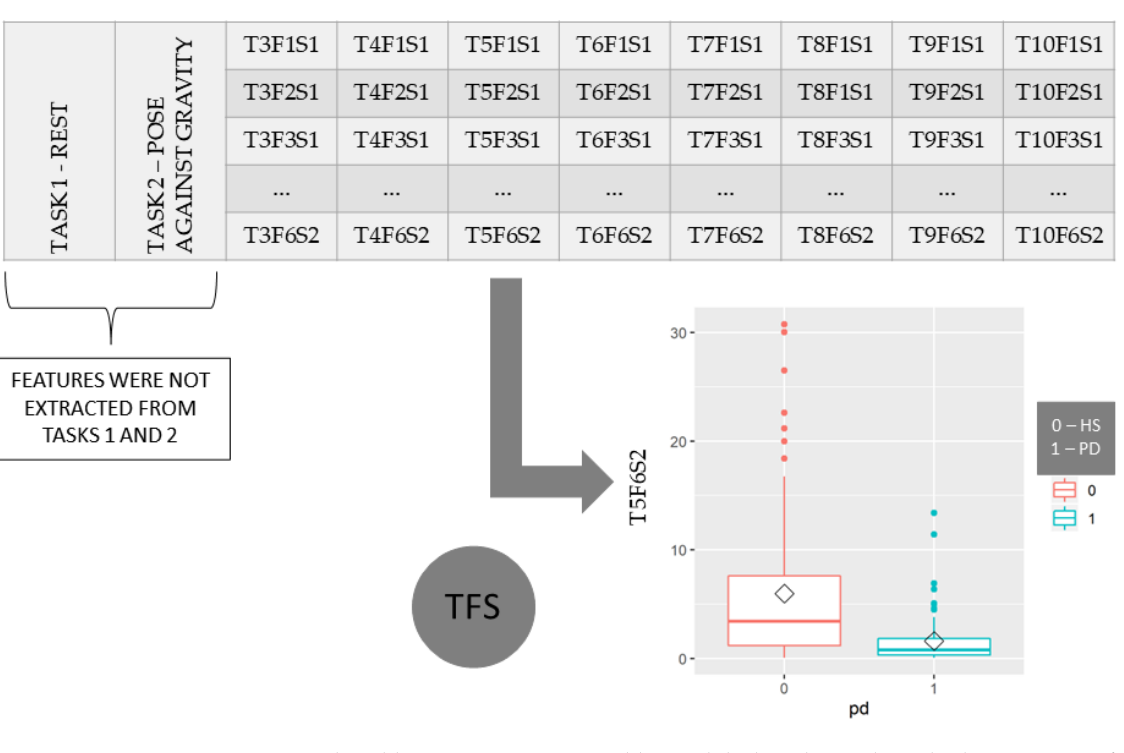
Figure 7. The table contains 96 TFS variables, and the boxplot on the right depicts T6F6S2 for the HS and PD groups.